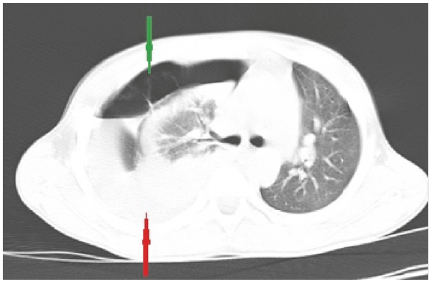
Figure 1: Thoracic CT scan showing the presence of digestive loops (green arrow), and right lobe of the liver (red arrow) with compression of the right lung and shift of the mediastinum to the